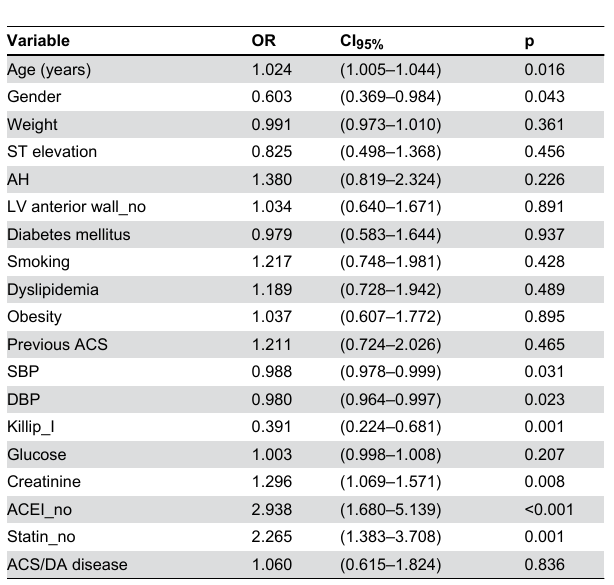
Table 3. Multivariate regression analysis for the primary outcome “beta-blocker intolerance”.